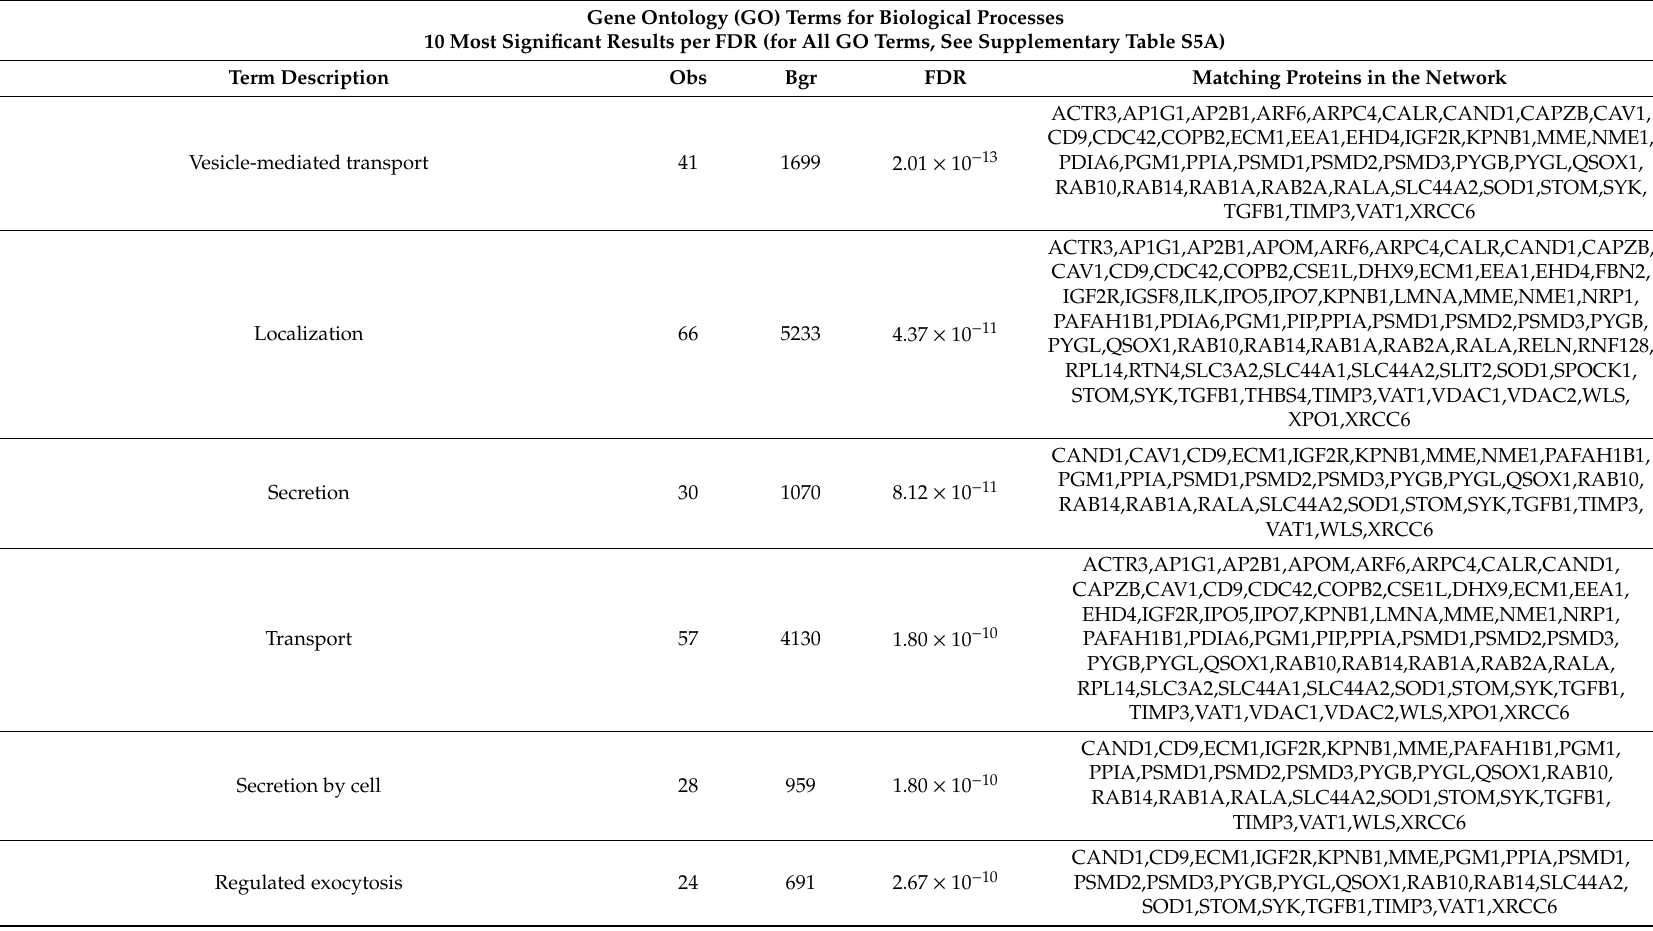
Table 10. Biological processes, KEGG pathways, and PMIDs for the EV total unique proteins in the HIV + A β group for the HIV vs. HIV + A β comparison. Gene Ontology (GO) Terms for Biological Processes 10 Most Significant Results per FDR (for All GO Terms, See Supplementary Table